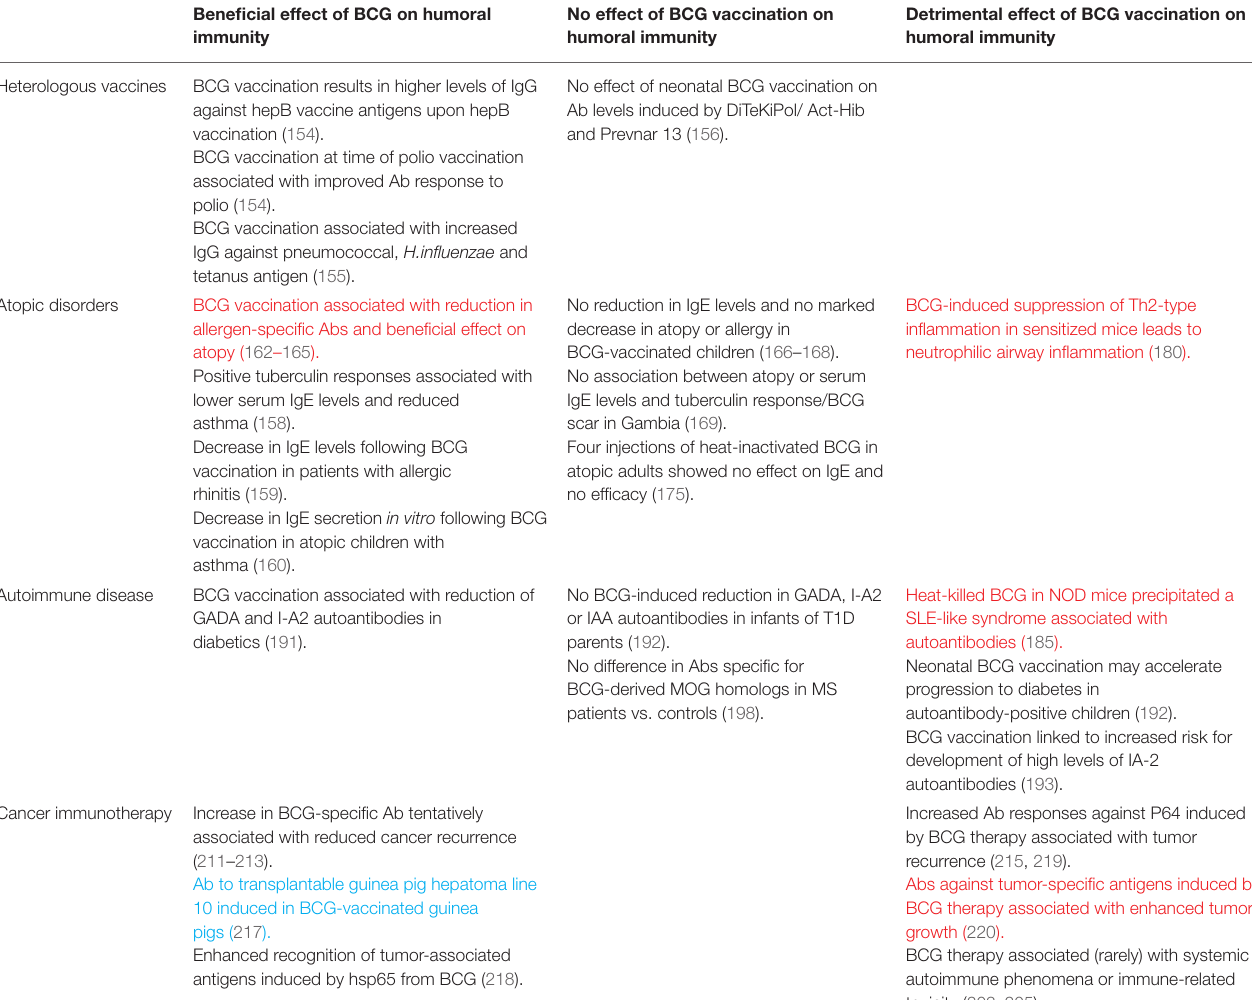
TABLE 3 | Summary of evidence for off-target humoral immunomodulatory effects of BCG vaccination discussed in this